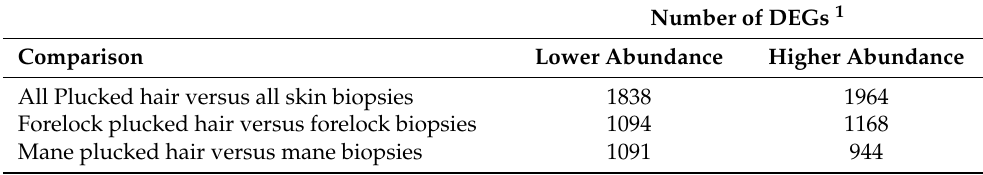
Comparison Lower Abundance Higher Abundance All Plucked hair versus all skin biopsies